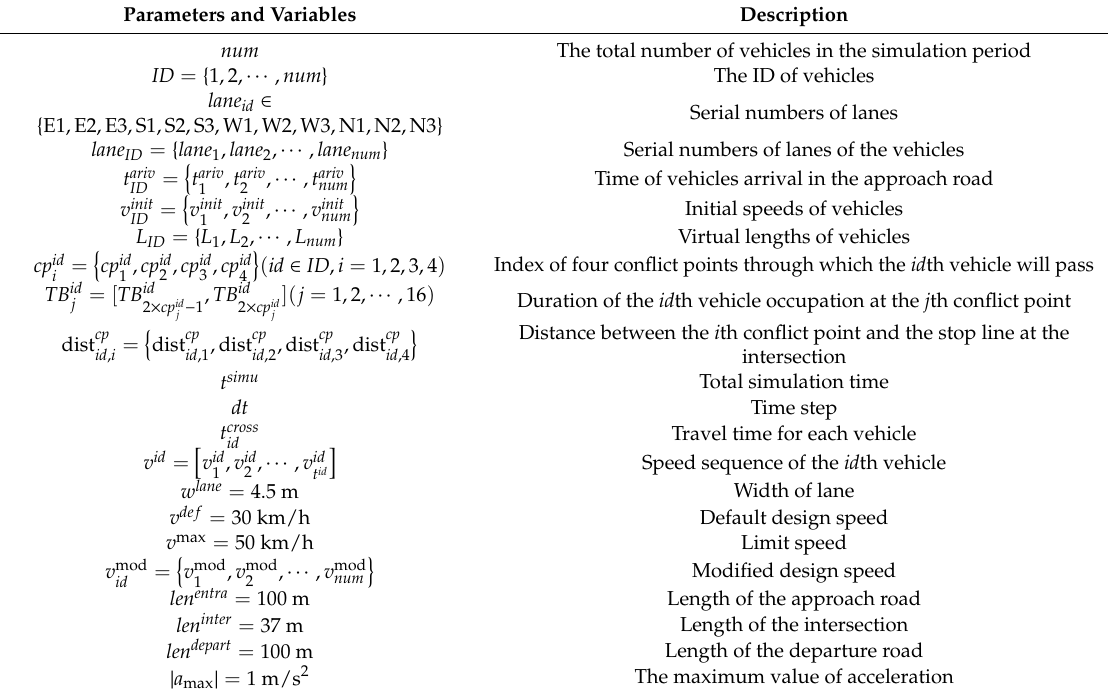
Table 2. Notations and